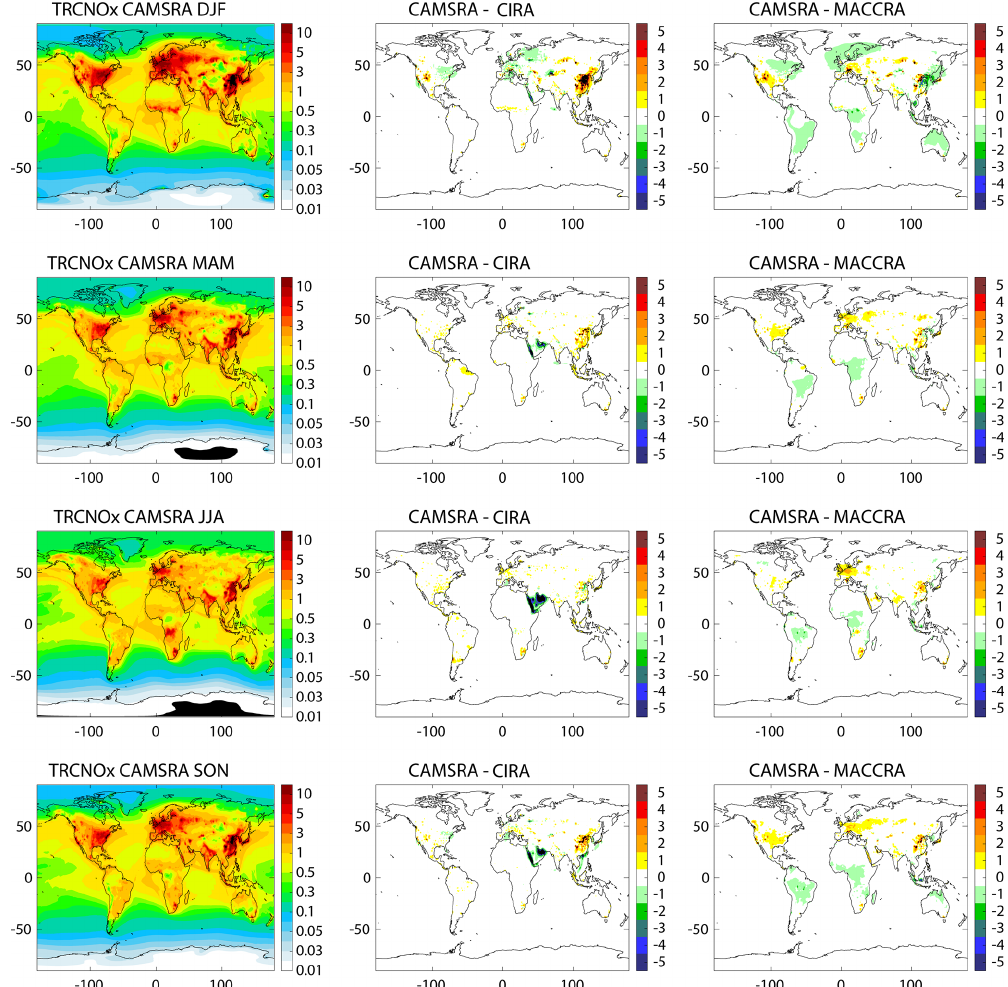
Figure 17. Seasonally averaged TRCNOx in 10 15 moleccm − 2 from CAMSRA (2003–2016, left), the differences between CAMSRA and CIRA (middle), and the differences between CAMSRA and MACCRA (right, 2003–2012 only) for the seasons DJF (row 1), MAM (row 2), JJA (row 3) and SON (row